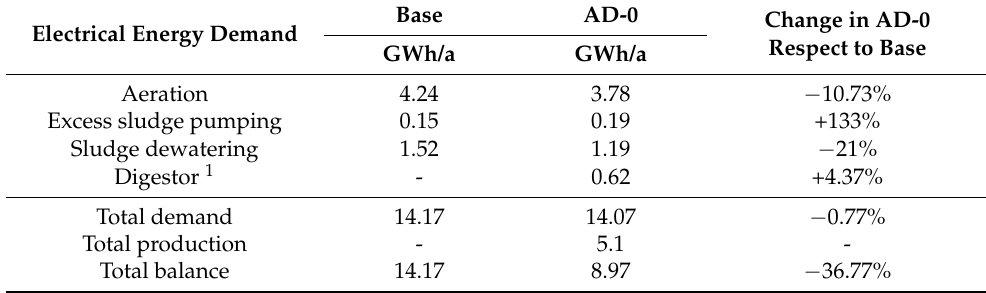
Table 3. Changes in electrical energy consumption per year between scenarios Base and